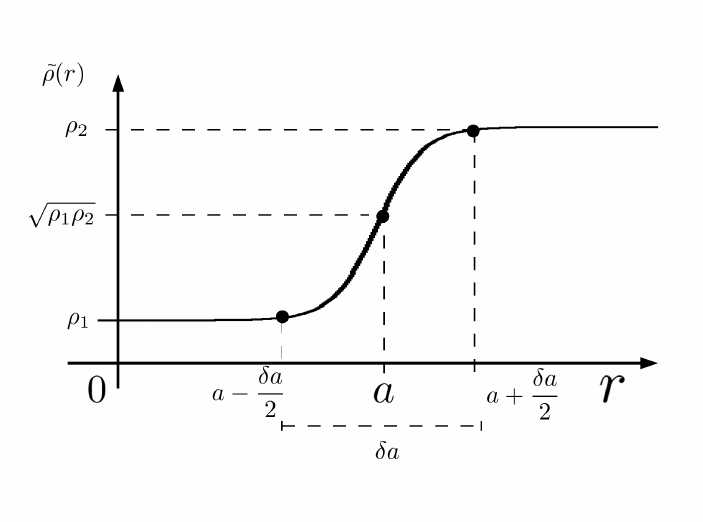
Figure 2 - Sketches a model (see Eq. 18) to the behavior of the density (cid:101) ρ around the bubble interface between water and air, where it is assumed that a thin layer of width δa separates the two media. The inner medium (the air) has density ρ 1 and ρ 2 is the density of the outer medium